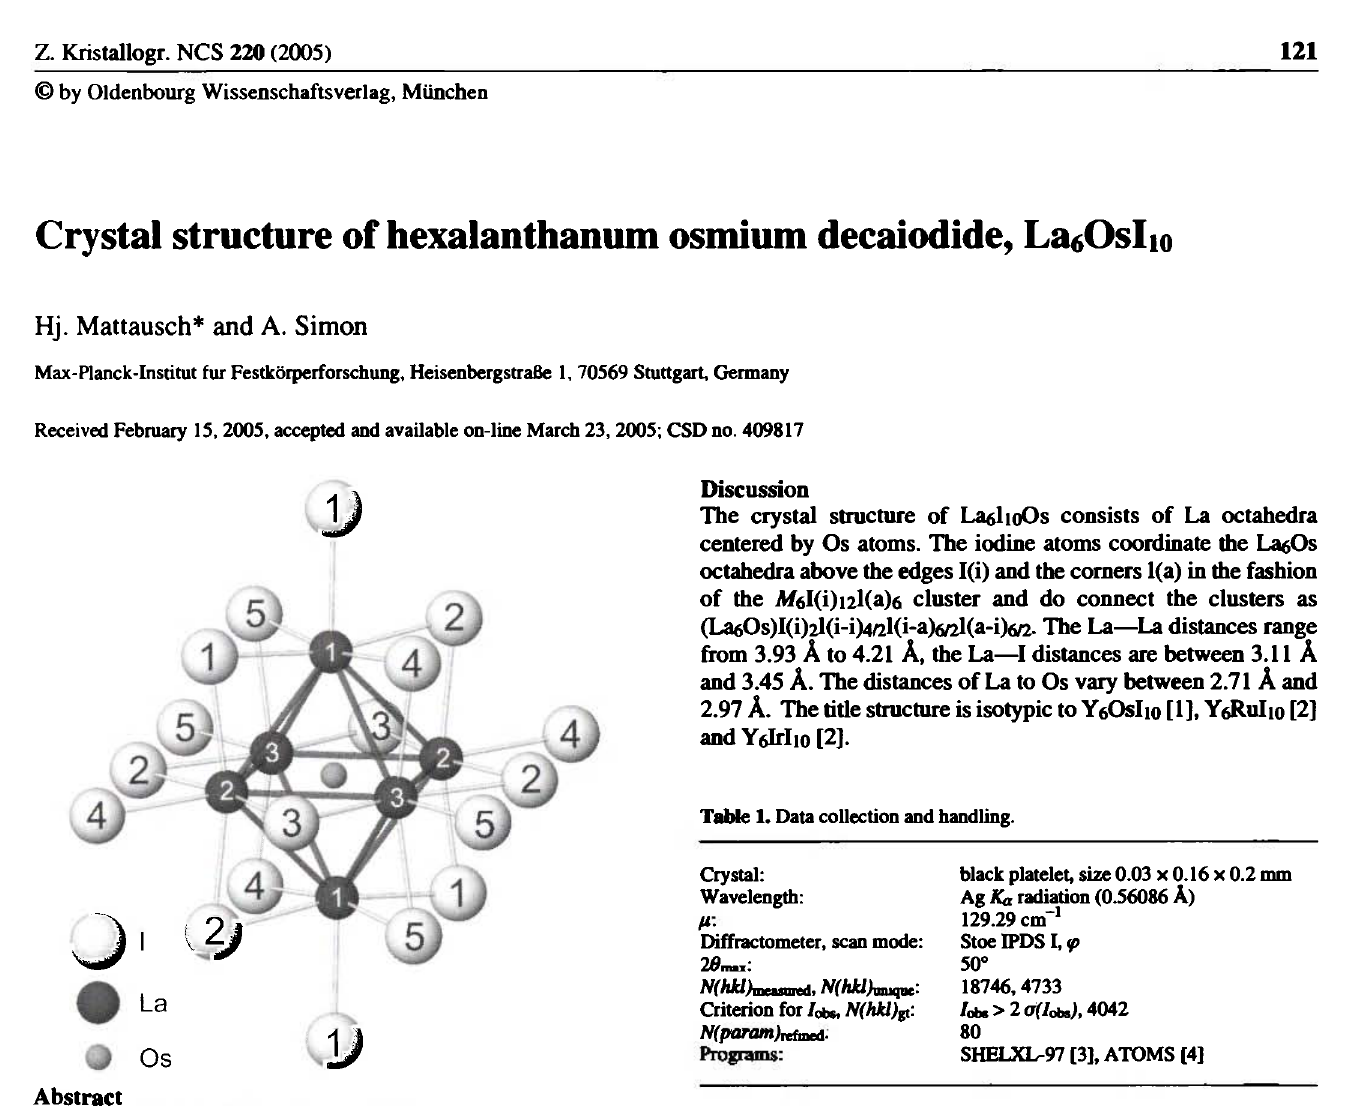
Table 1. Data collection and handling. Crystal: Wavelength: